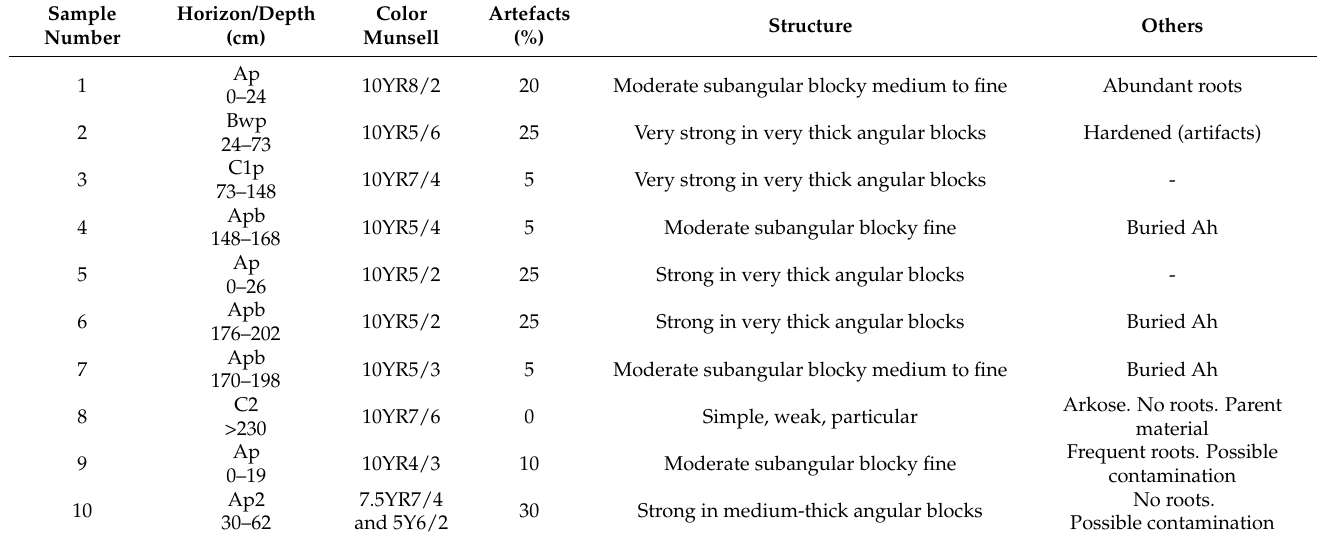
Table 1. Important features of the profile’s